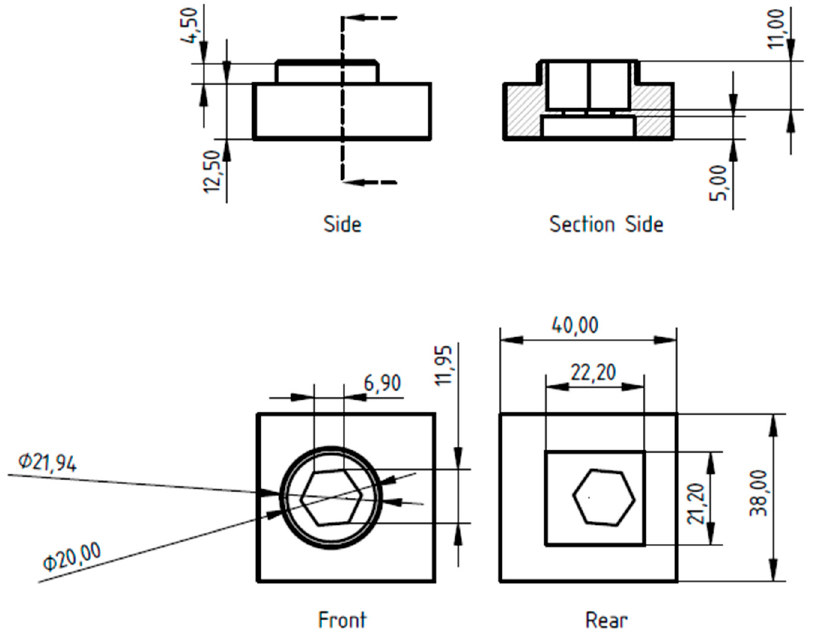
Figure A4. Technical drawing of the spectrometer sensor mount for measuring incident photon flux density. Dimensions in mm. A comma is used as decimal separator in this figure.